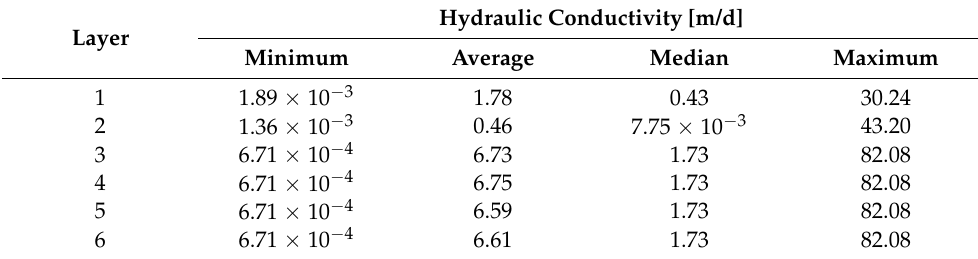
Figure 7. Cell status within layer 1 at the model calibration stage (white—active cells; grey—inactive; blue—rivers with good hydraulic contact with groundwater, I type boundary condition; light blue—rivers with limited hydraulic contact with groundwater, III type boundary condition). Table 1. Variation in hydraulic conductivity in different model layers, after model calibration.